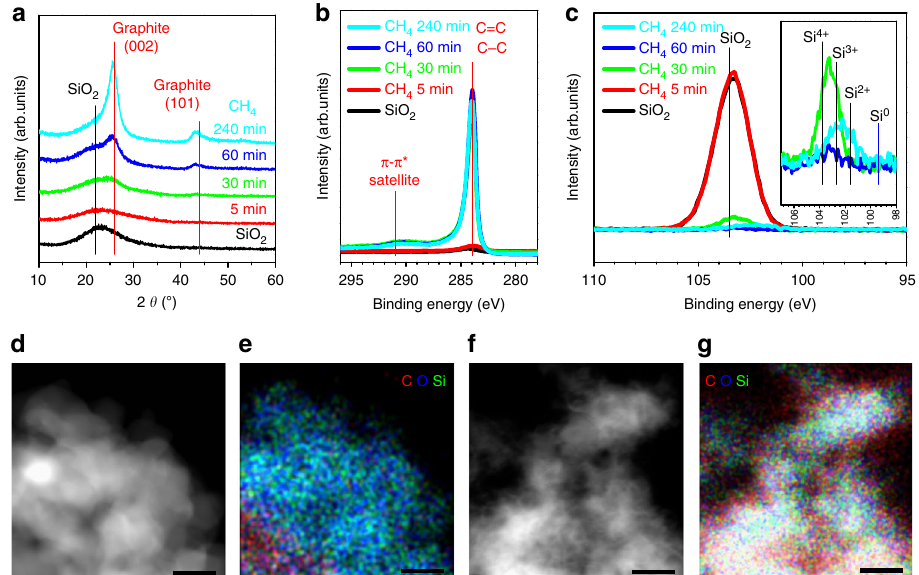
Fig. 2 Analysis of graphene-ball during its growth. a – c Monitoring graphene growth during the course of the CVD process using a XRD, b XPS in C 1s branch, and c XPS Si 2p branch. d – g EDX elemental mapping with respect to C, O, and Si after d , e 5 min and f , g 30 min graphene growth from SiO 2 (scale bars, 50 nm)